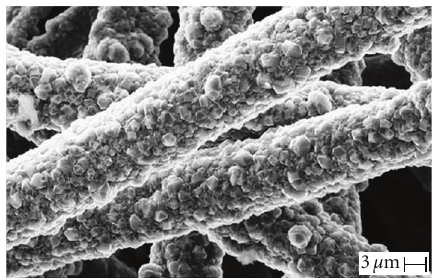
Figure 17: SEM image of BDD/CF electrode with a doping level of 10 18 part cm − 3 (reprinted with permission from [78]).